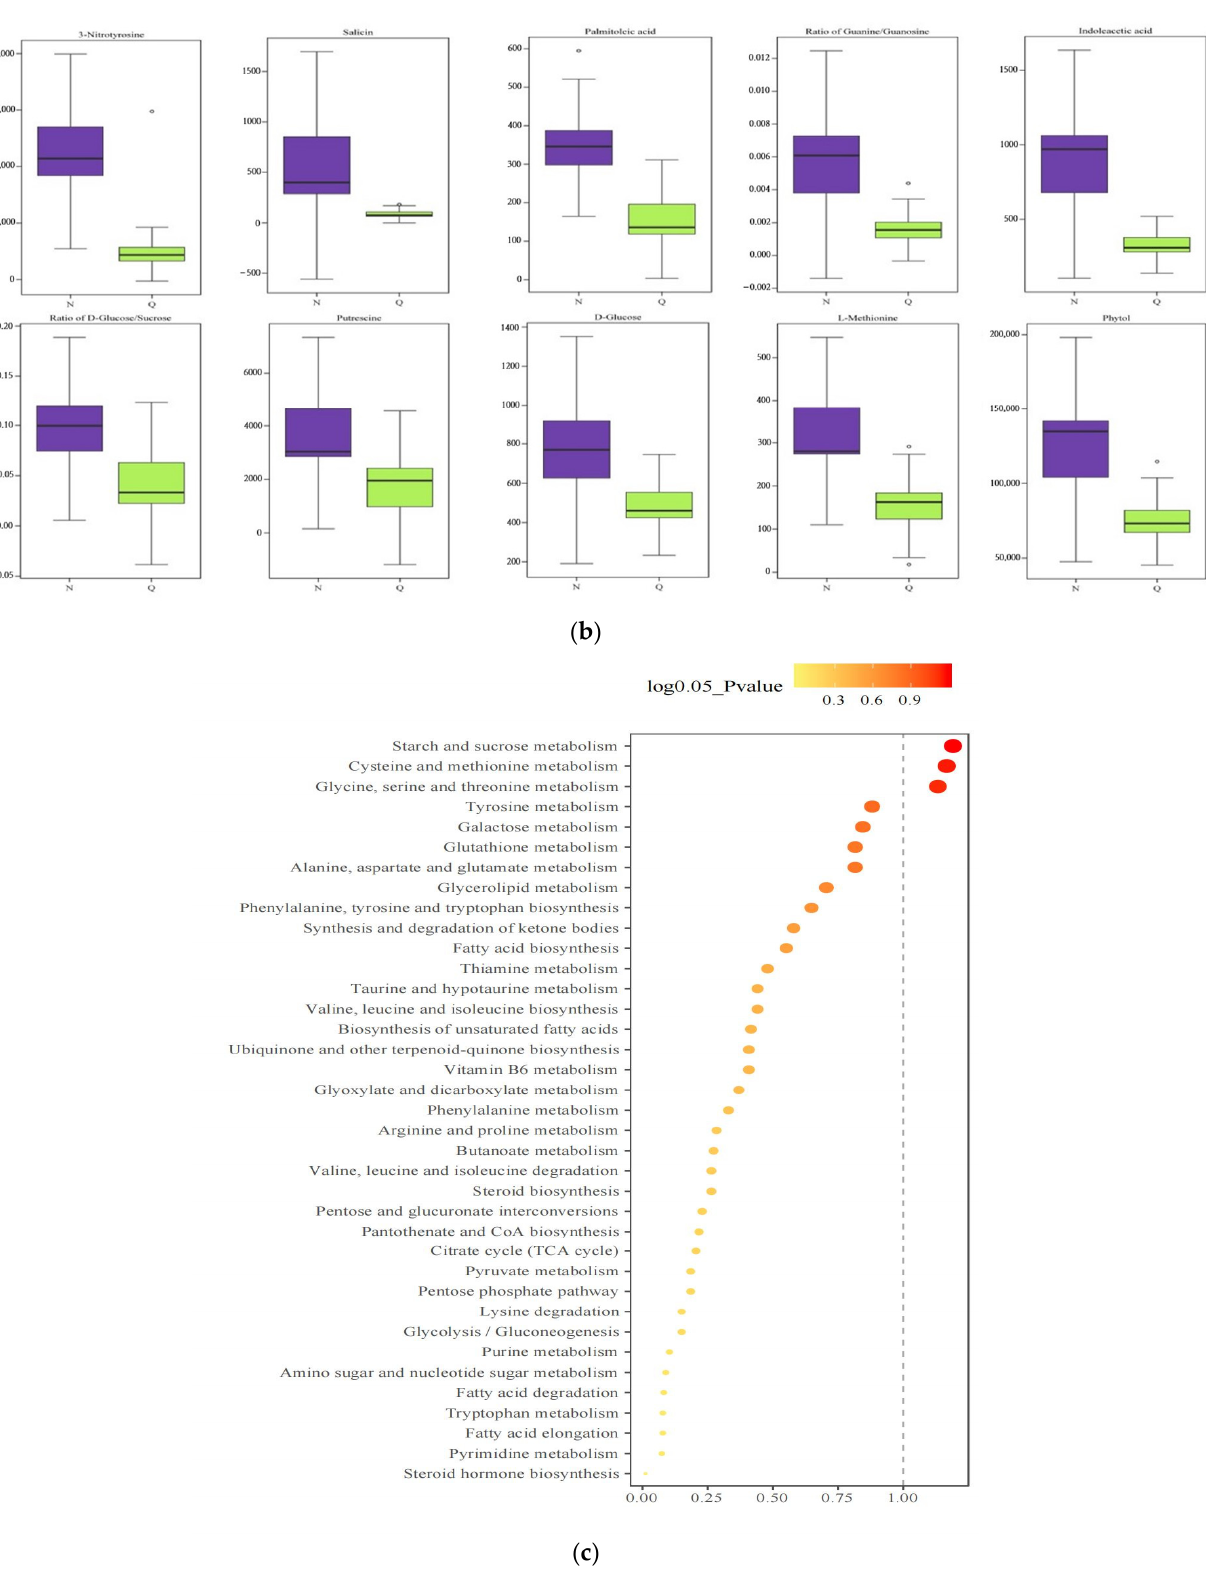
Figure 2. ( a ) Up-regulated metabolites of R. chrysanthum between control and domestication; ( b ) Down-regulated metabolites of R. chrysanthum between control and domestication; ( c ) Metabolic Pathway Enrichment Analysis of differentially expressed metabolites that are R. chrysanthum plants under UV-B irradiation.